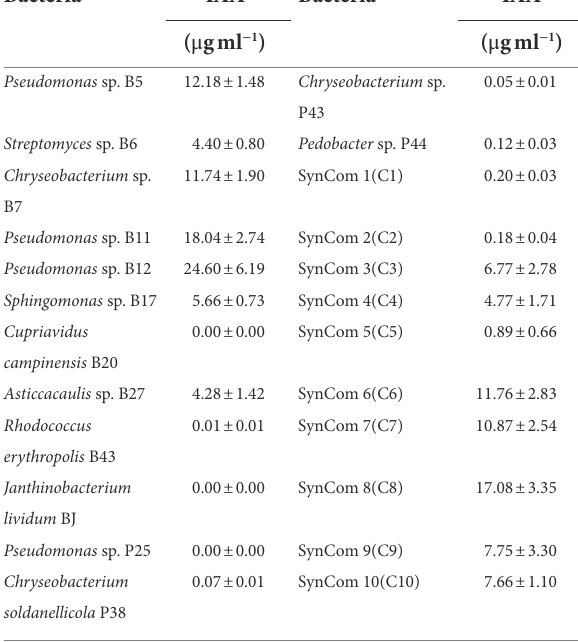
TABLE 3 Indole acetic acid (IAA) produced by